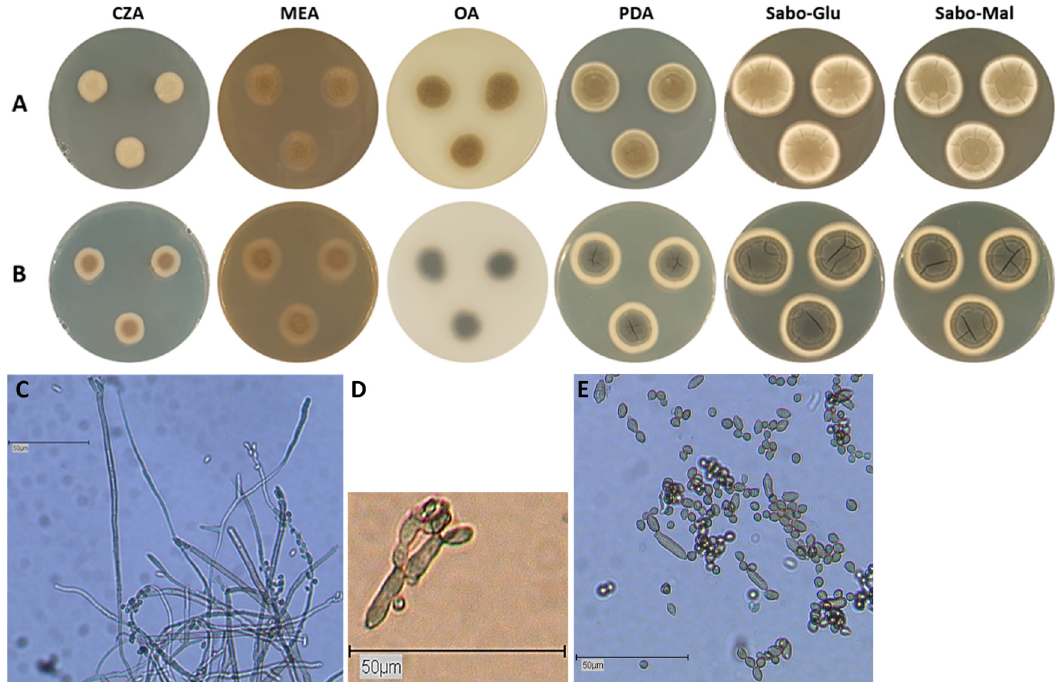
Figure A3. Macroscopic and microscopic characteristics of Cladosporium cladosporioides . Growth was studied on different culture media ( A ). A 20 µL spore suspension (5 × 10 5 spores per mL) was pipetted three times onto different solid media and incubated at 21 °C for five days. ( A ) Surface growth and ( B ) colony reverse were documented photographically. Using transmitted light microscopy (light microscope DMRBE, Leica, Wetzlar, Germany), hyphal growth, ( C ) conidiophore structure and ( D , E ) spores of Cladosporium cladosporioides were examined.